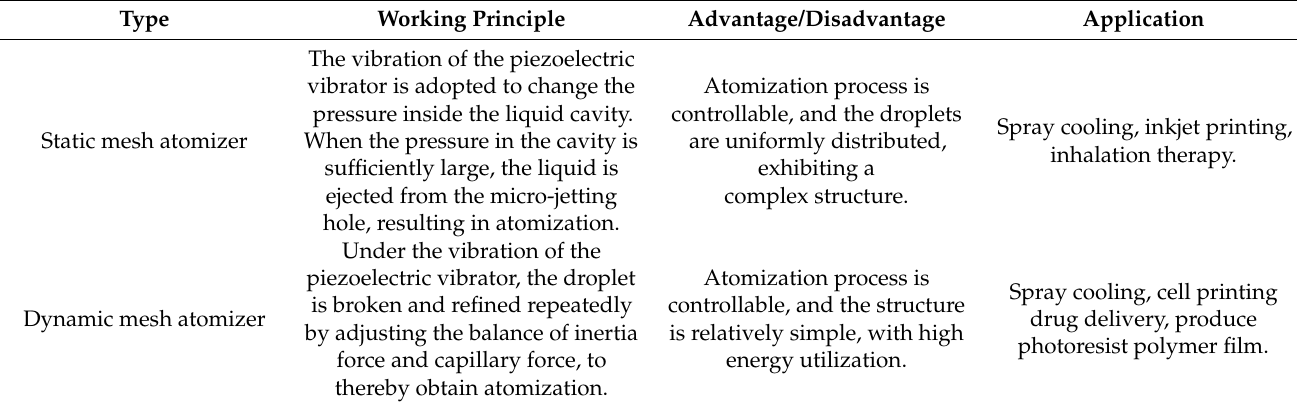
Table 1. Working principle, characteristics, and application of different types of piezoelectric atomizers.